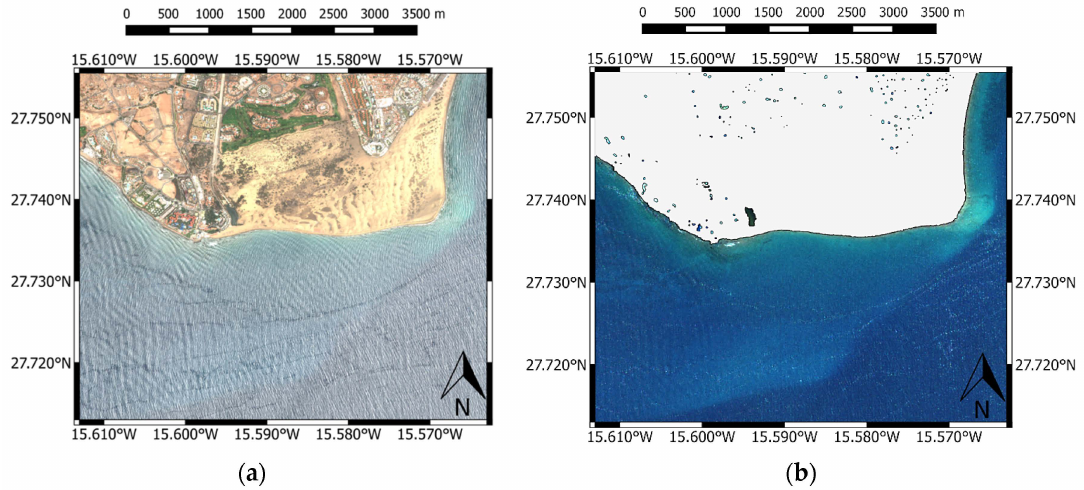
Figure 7. ( a ) WV-2 image of Maspalomas before deglinting removal; ( b ) image after